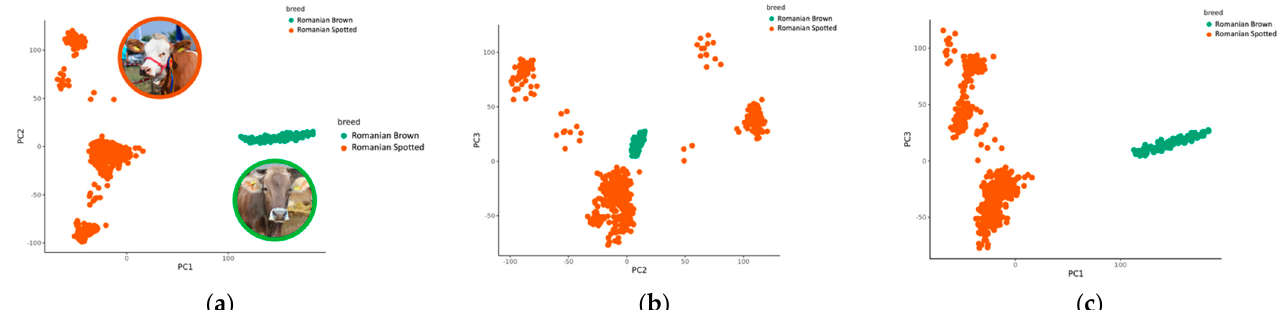
Figure 1. Population structure from the principal component analysis of the 40,305 single nucleotide polymorphisms (SNPs) and 690 cattle. Population structure is presented as pairwise scatter plots ( a – c ) of the first three principal components (PC), with green and orange dots representing the two breeds (Romanian Spotted in orange and Romanian Brown in green). ( a ) PC1 vs. PC2; ( b ) PC2 vs. PC3; ( c ) PC1 vs. PC3.